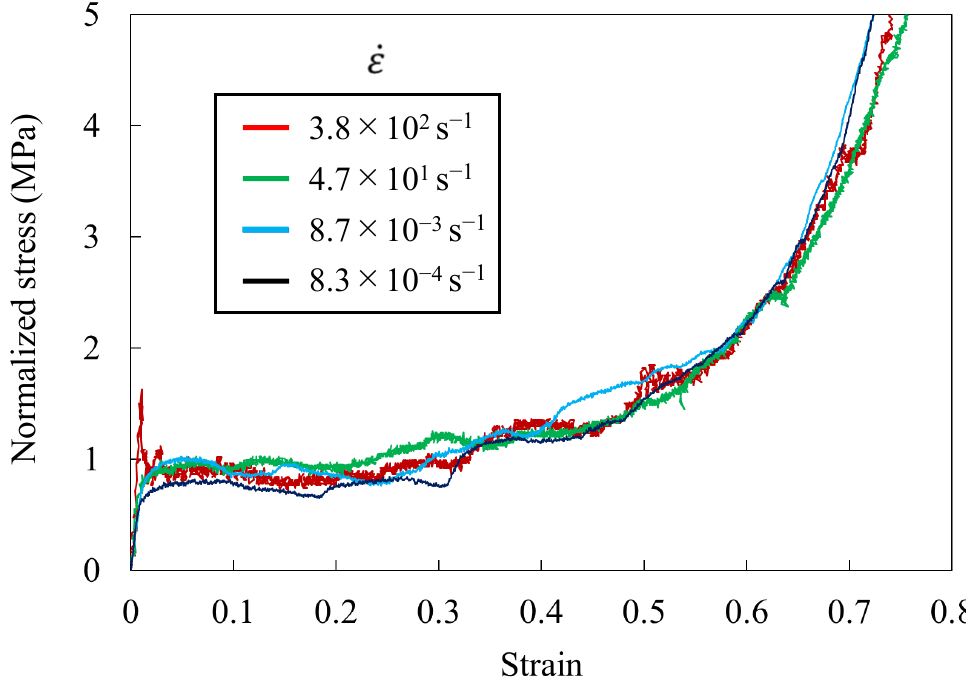
Figure 8. Typical normalized stress–strain relationship of Ni foam at a strain rate between 8.3 × 10 −4 and 3.8 × 10 2 s −1 .